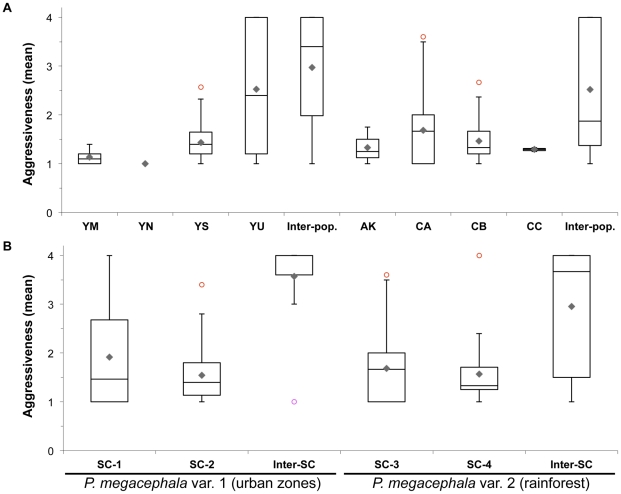
Average intra- and inter-group aggressiveness between P. megacephala workers.Box-plots indicate median (horizontal line), mean (diamond), interquartile range (box) and minimum and maximum values (whiskers). Nests are assigned to their population (A) or supercolony (B). (AK: Akok; CA, CB and CC: Campo Forest Reserve; YM, YN, YS and YU: Yaoundé and its periphery).